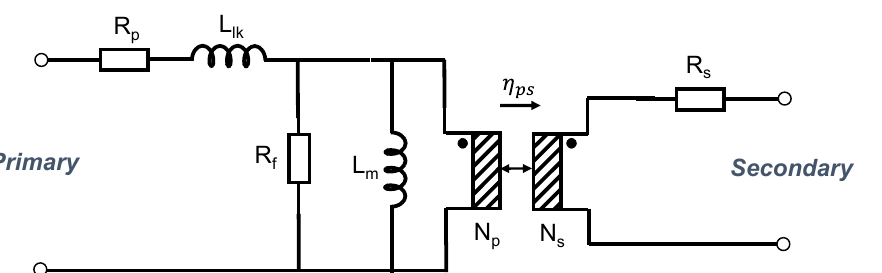
Figure 8. Planar transformer impedance measurements: ( a ) modulus; ( b ) phase; ( c ) measurement configurations.